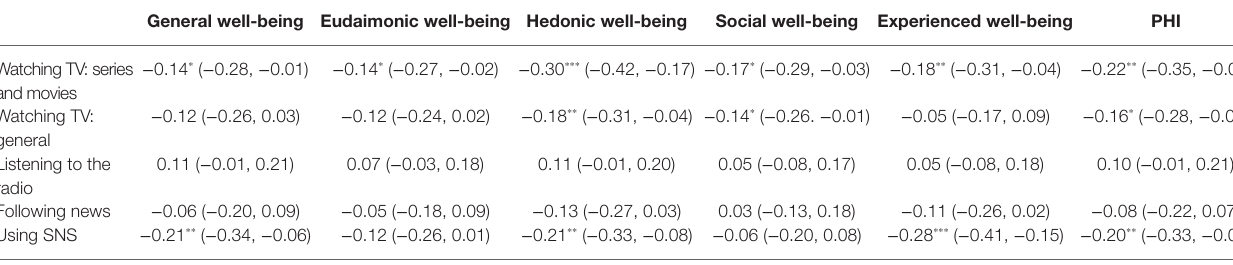
TABLE 4 | Pearson bivariate correlations between change in habits and happiness dimensions. General well-being Eudaimonic Hedonic well-being Social well-being Experienced well-being